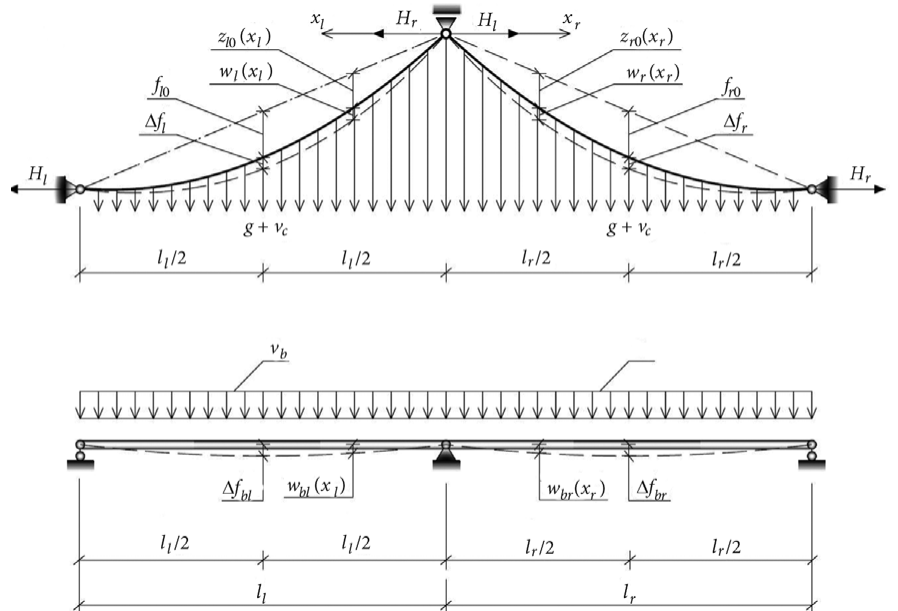
Fig. 2. Schemes for the calculations on the suspension